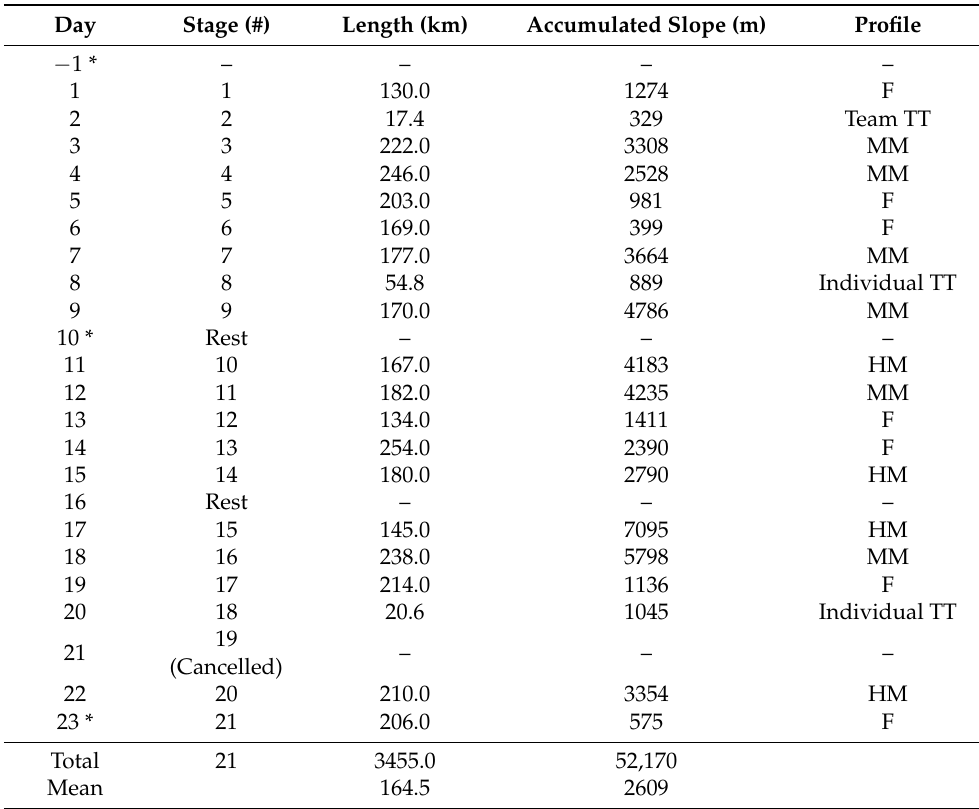
Table 1. Main features of the Giro d’Italia 2013 route. Day Stage